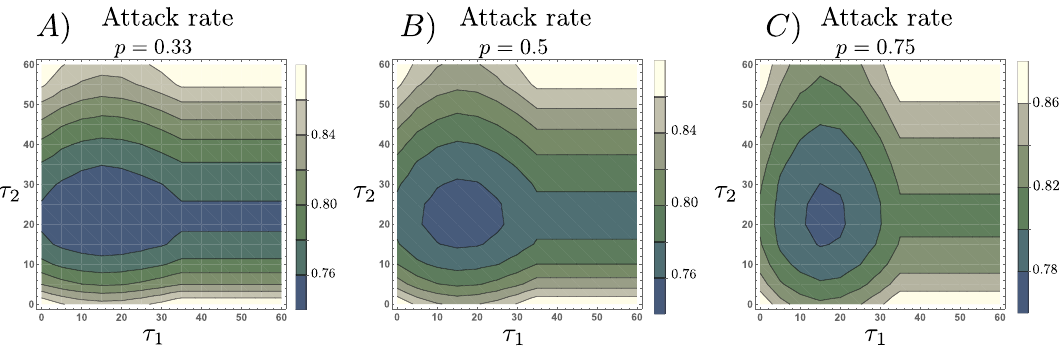
Figure 8. There is a set of planning horizons minimizing the attack rate. The figure shows attack rate level curves as a function of the risk-takers and risk-evaders planning horizons, τ 1 and τ 2 , respectively. Differences in group-specific infection risks ( β and ǫβ ) and group-specific risk assessment modify the optimal planning horizon. The set of parameters used are those in Table